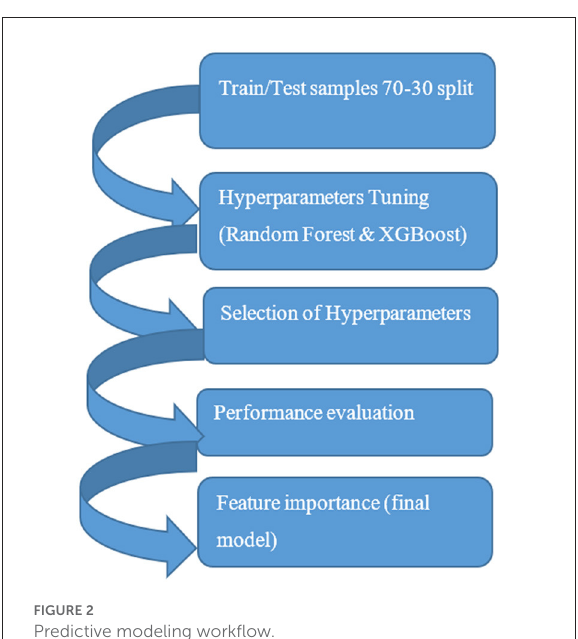
FIGURE2 Predictive modeling